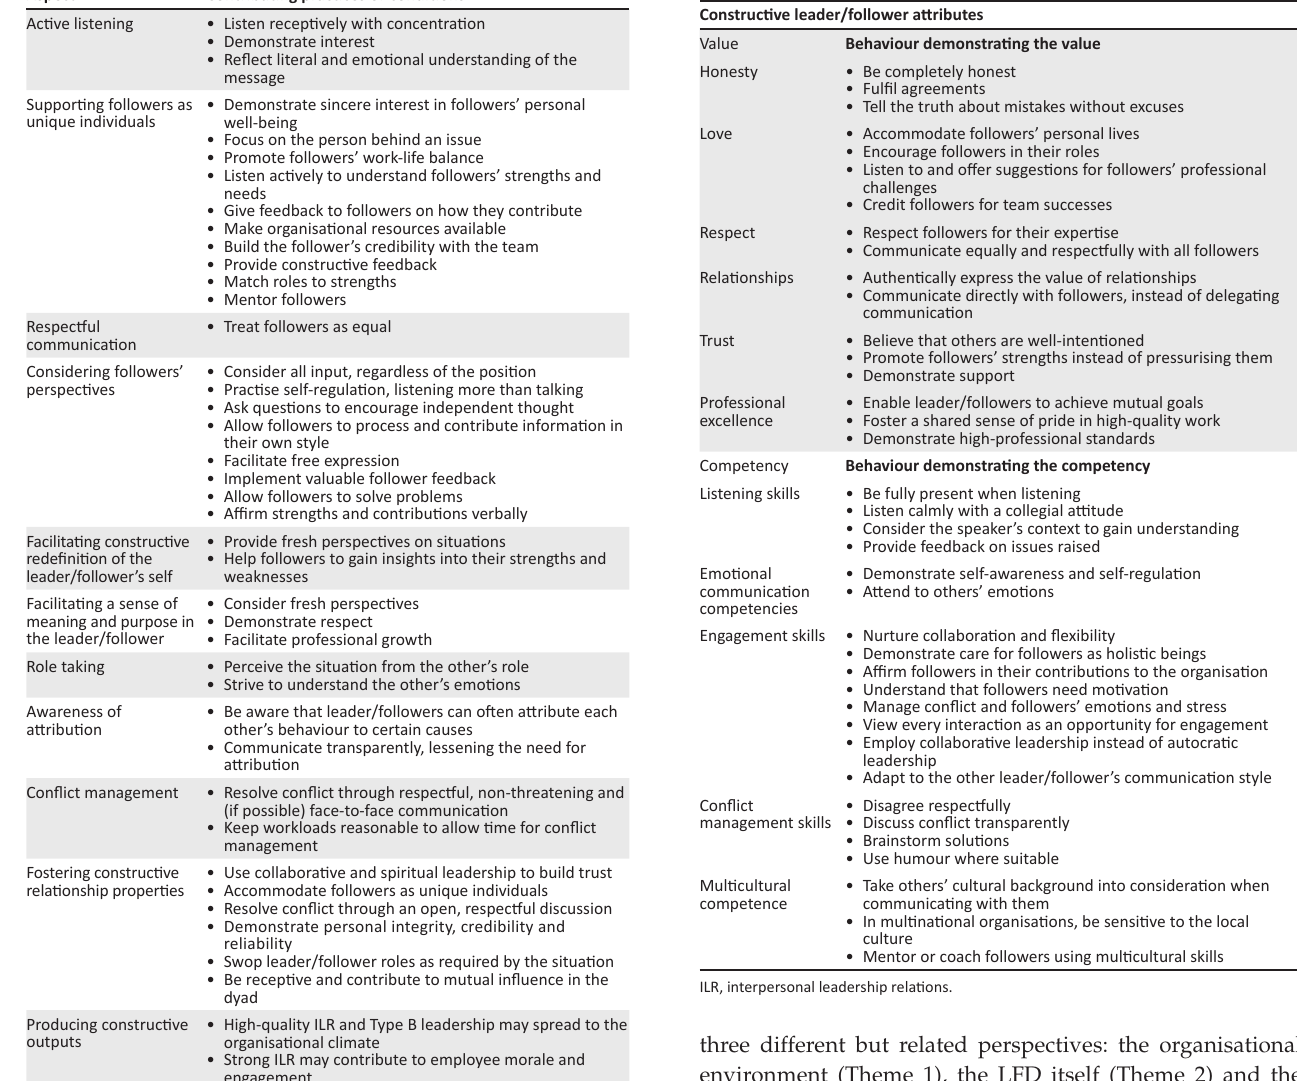
TABLE 5: Leader/follower attributes that enhance interpersonal leadership relations.